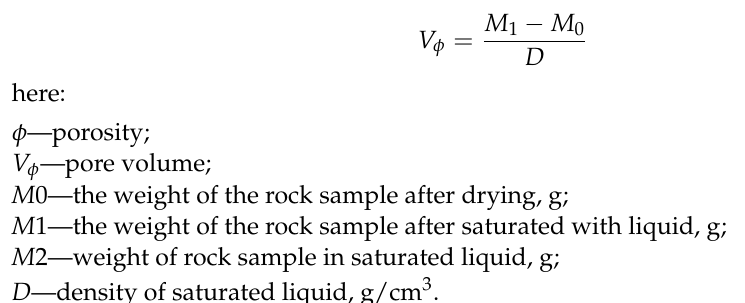
Figure 15. Curve of elastic index variation of a typical core under different stress changes.